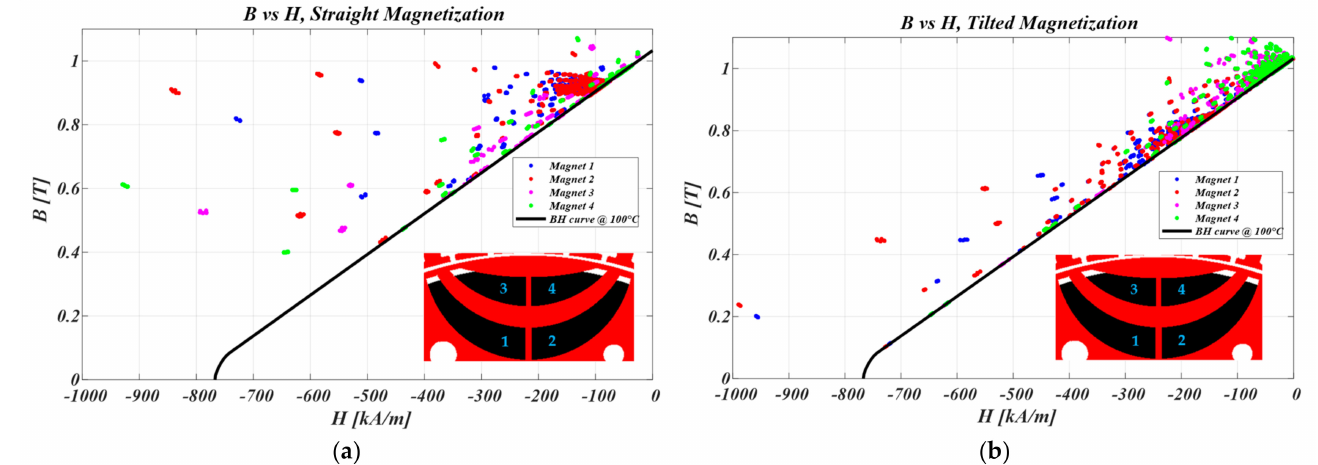
Figure 11. Magnet nodes BH values for each position in one electrical period and magnet demagneti- zation curve at 100 ◦ C. ( a ) Baseline motor BH values for straight magnetization; ( b ) Baseline motor BH values for tilted magnetization.